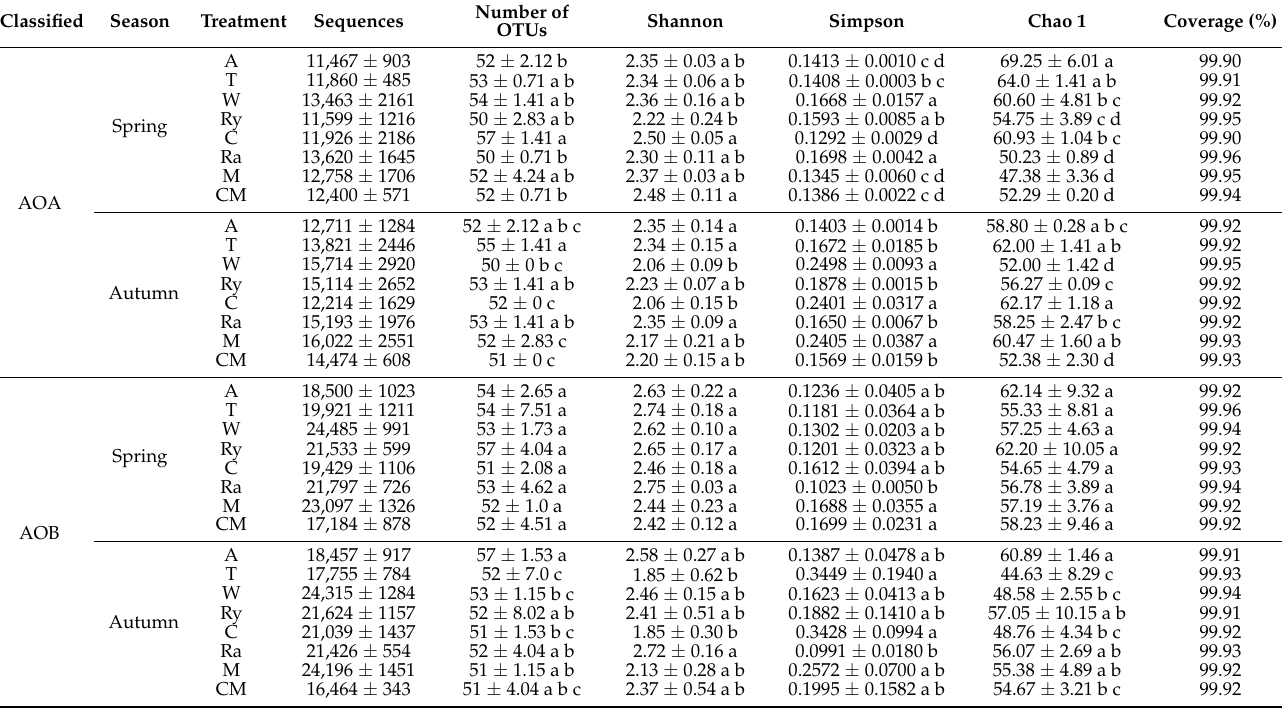
Table 3. Illumina MiSeq sequencing results and alpha diversity estimates for soil AOA and AOB communities.